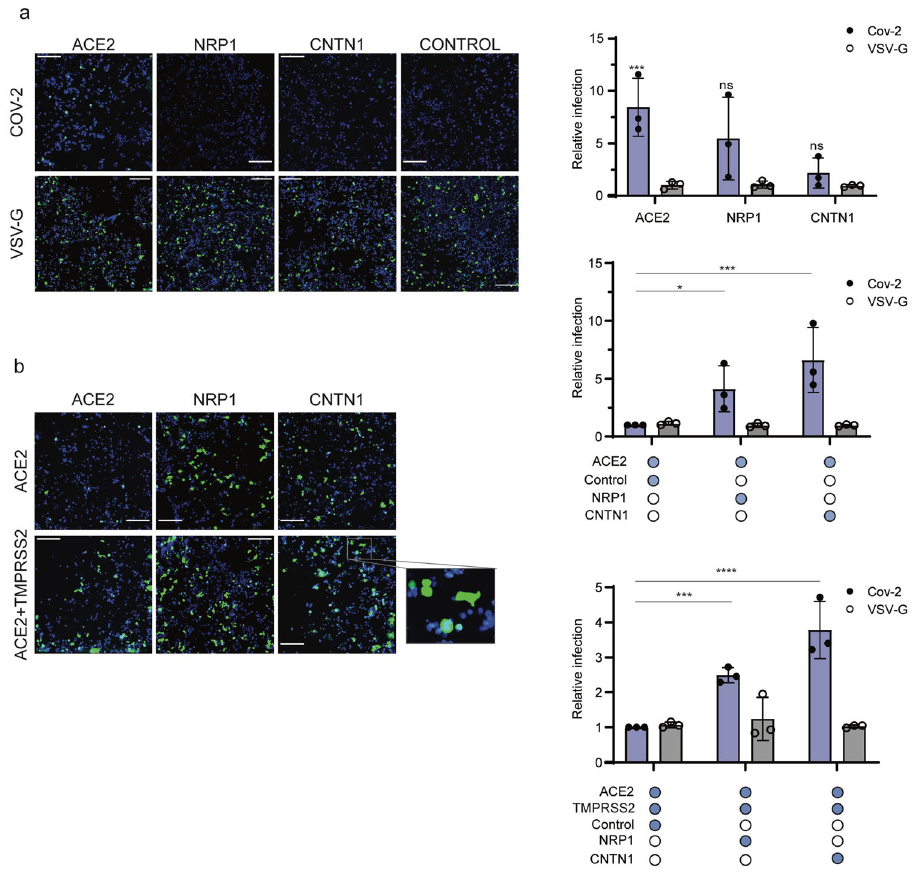
Fig. 6 CNTN1 enhances ACE2-dependent entry of SARS-CoV-2 spike pseudotyped particles. a Representative images and quanti fi cation of SARS CoV-2 pseudotyped particle infection (blue bars) of HEK/293T cells transiently expressing the RBD receptors ACE2, CNTN1 and NRP1. b HEK/293T cells transiently expressing ACE2, or ACE2 and TMPRSS2 were transfected with CNTN1 or NRP1 and subsequently infected with SARS CoV-2 pseudotyped particles (blue bars). VSV-G pseudotyped infection was used as control (grey bars). Data are normalized to the respective infection of SARS CoV-2 and VSV-G particles in (top graph) control protein-expressing, (middle graph) ACE2-expressing or (bottom graph) ACE2 + TMPRSS2-expressing cells. Infected cells are represented in green; nuclei are depicted in blue. Scale bar = 200 µ m. Two-way ANOVA with Sidak ’ s correction for multiple comparisons; * p < 0.05, p < 0.001. NS, not signi fi cant. Data shown represents mean ± s.d. from three independent